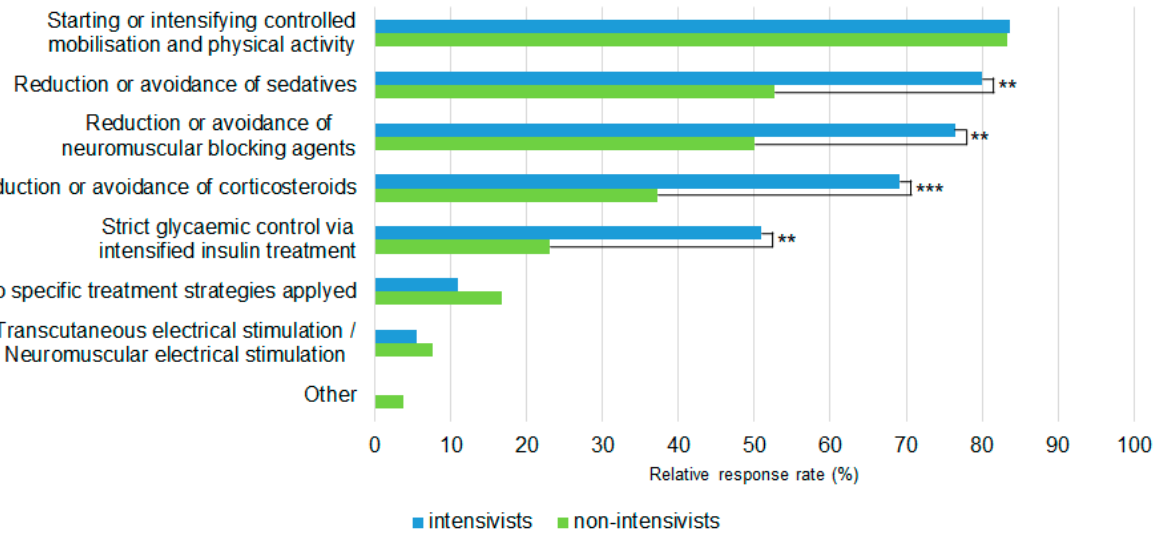
Figure 2. Treatment and prevention strategies between intensivists (primary specialty) and non- intensivists. **: p < 0.01. ***: p < 0.001.